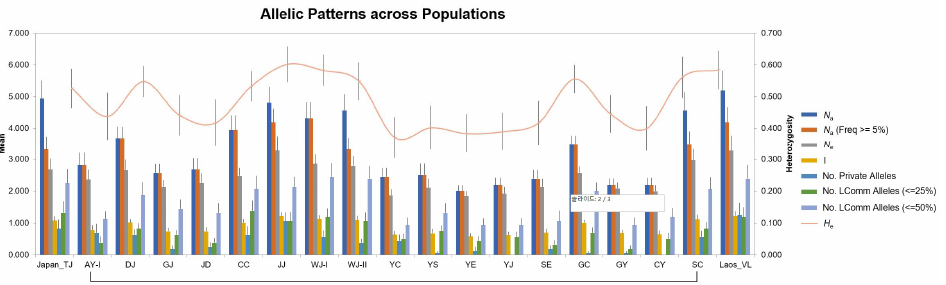
Figure 5. Mean allelic patterns across 19 populations of Aedes albopictus. N a = No. of Different Alleles; N a (Freq ≥ 5%) = No. of Different Alleles with a Frequency ≥ 5%; N e = No. of Effective Alleles = 1/(Sum pi 2 ); I = Shannon’s Information Index = −1* Sum (pi * Ln (pi)); No. Private Alleles = No. of Alleles Unique to a Single Population; No. LComm Alleles (≤25%) = No. of Locally Common Alleles (Freq. ≥ 5%) Found in 25% or Fewer Populations; No. LComm Alleles (≤50%) = No. of Locally Common Alleles (Freq. ≥ 5%) Found in 50% or Fewer Populations; Yellow line is H e = Expected Heterozygosity = 1 − Sum pi 2 .